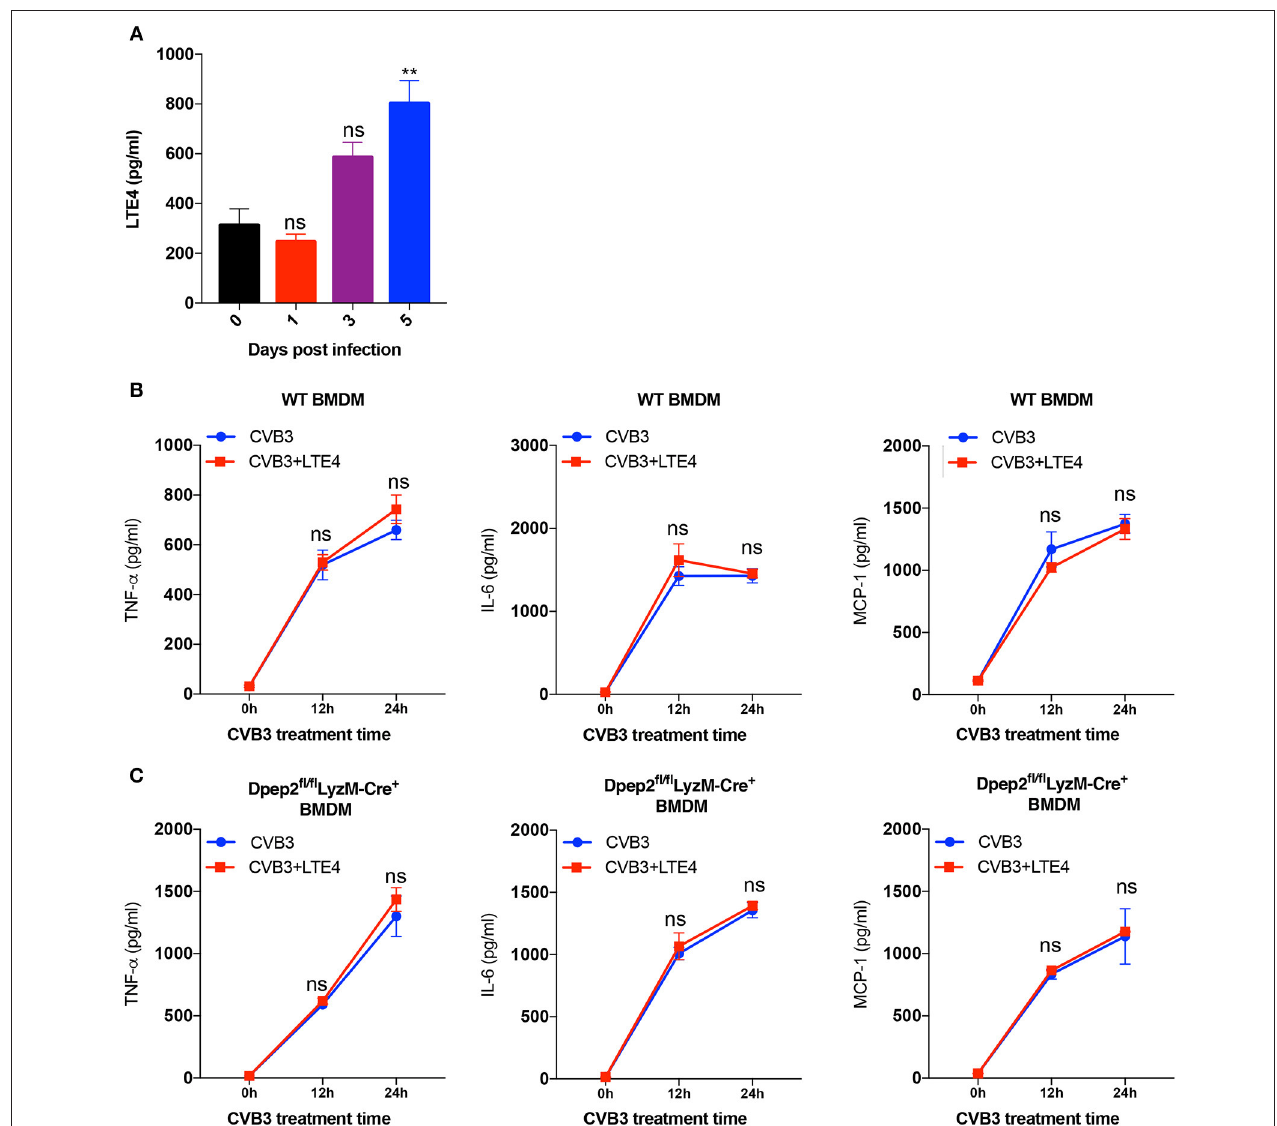
FIGURE 5 | Anti-inflammatory properties of Dpep2 did not rely on the conventional hydrolysate LTE4. (A) The kinetics of myocardial LTE4 were detected by ELISA on days 0, 1, 3, 5 post CVB3-infection. (B) WT BMDMs were incubated with CVB3 (MOI = 10) and LTE4 (100nM) for 12 or 24h. Levels of the pro-inflammatory cytokines TNF- α , IL-6, and MCP-1 in the supernatants were detected by ELISA. (C) Dpep2-deficient BMDMs were incubated with CVB3 (MOI = 10) and LTE4 (100nM) for 12 or 24h. Levels of the pro-inflammatory cytokines TNF- α , IL-6, and MCP-1 in the supernatants were detected by ELISA. Individual experiments were conducted three times with similar results and the representative data were shown. Data were presented as the means ± S.E.M. ** p < 0.01; ns, no